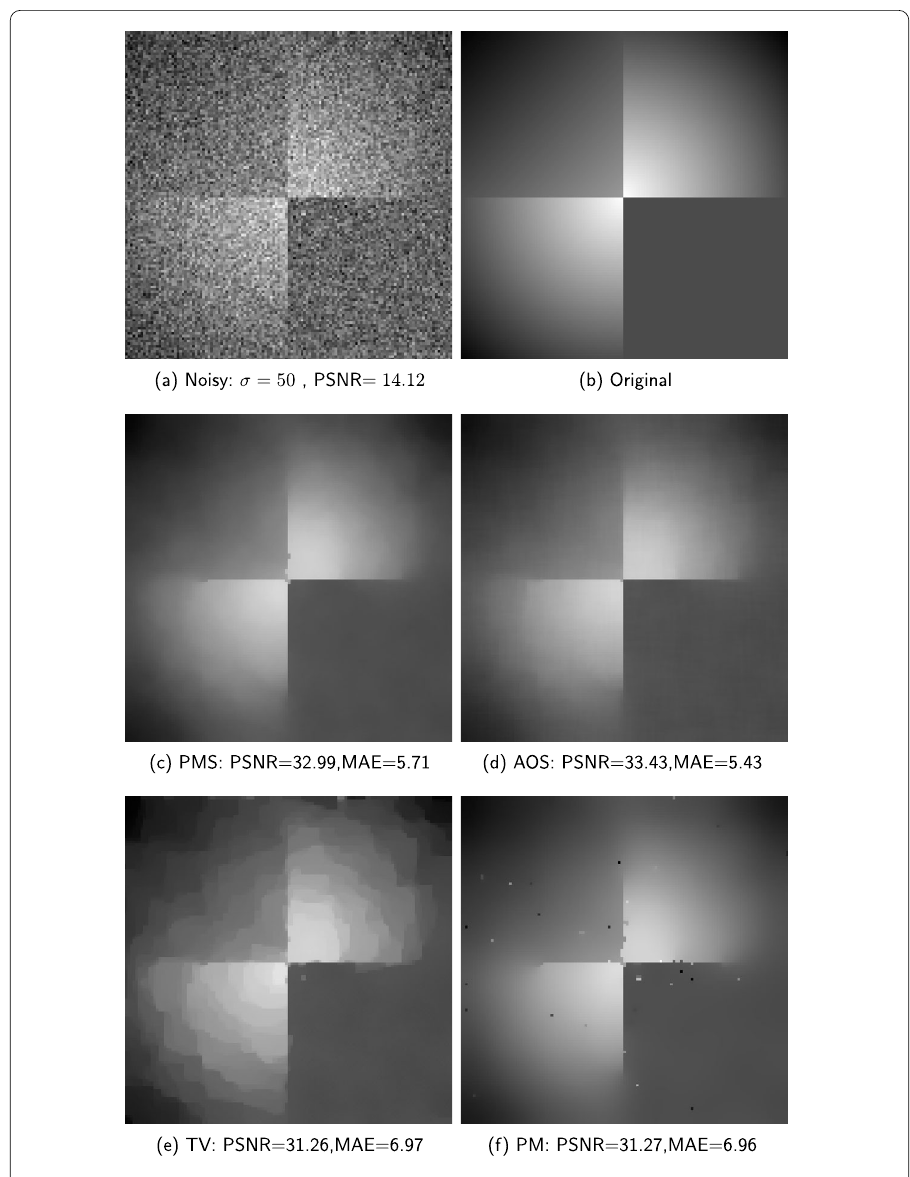
Figure 2 Synthetic image (128 × 128): ( a ) noisy image corrupted by Gaussian noise for σ = 50; ( b ) original image; ( c ) our algorithm by PMS, μ 1 = 0.3, μ 2 = 0.7, and τ = 0.2; ( d ) our algorithm by AOS, μ 1 = 0.9, μ 2 = 0.1, and τ = 2; ( e ) TV algorithm, τ = 0.2; and ( f ) PM algorithm, τ = 0.2 and K =